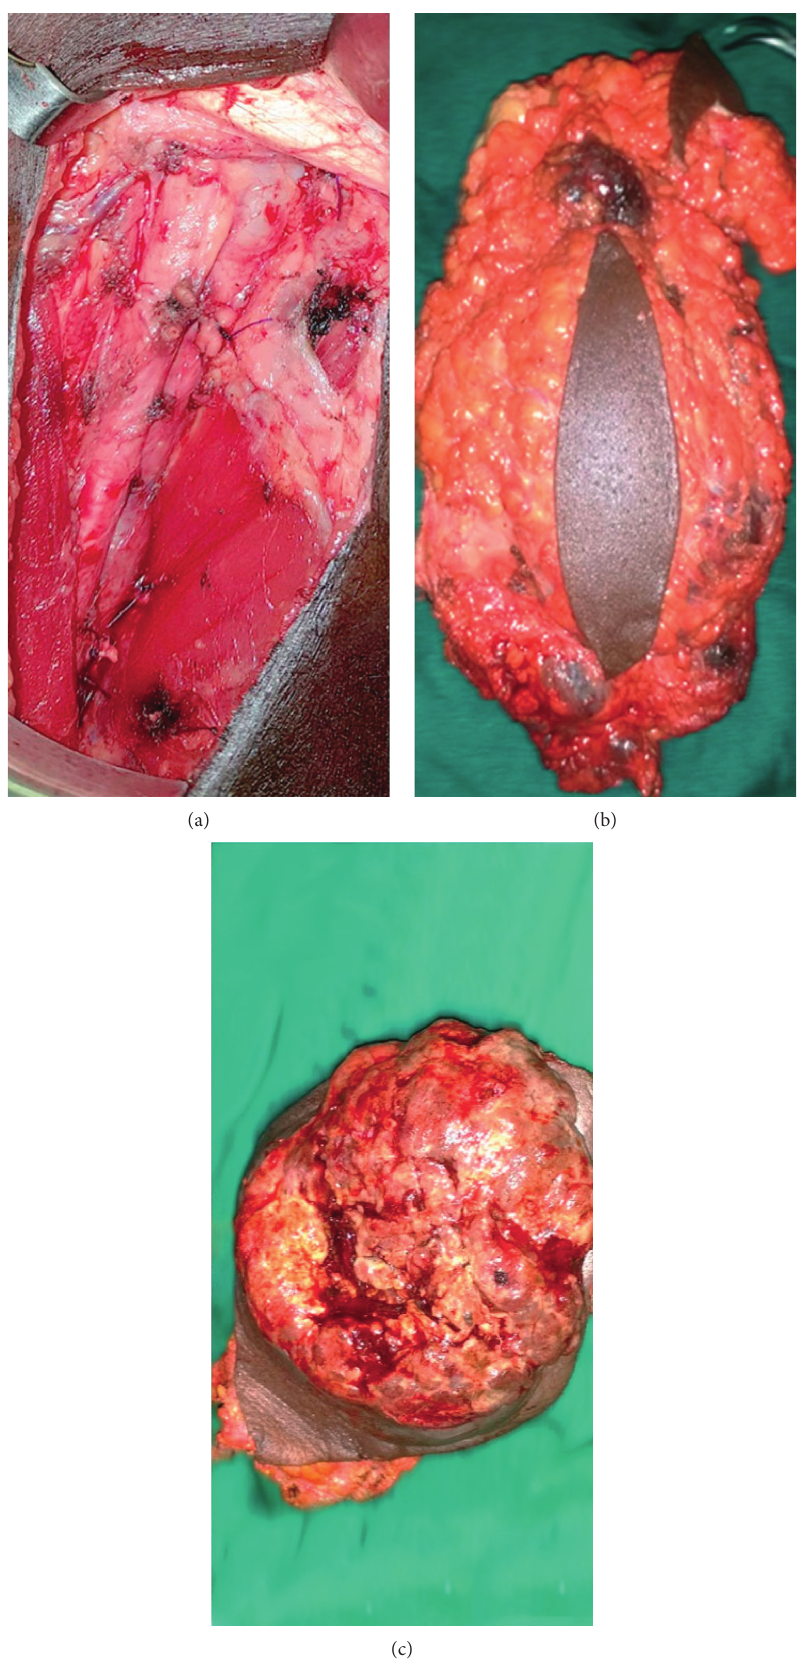
Figure 3: Ellipse-shaped inguinal lymph nodes dissection (ILND): (a) immediate postoperative aspect, (b) dissected lymph nodes and fat tissues, and (c) dissected ulceronecrotic lymph